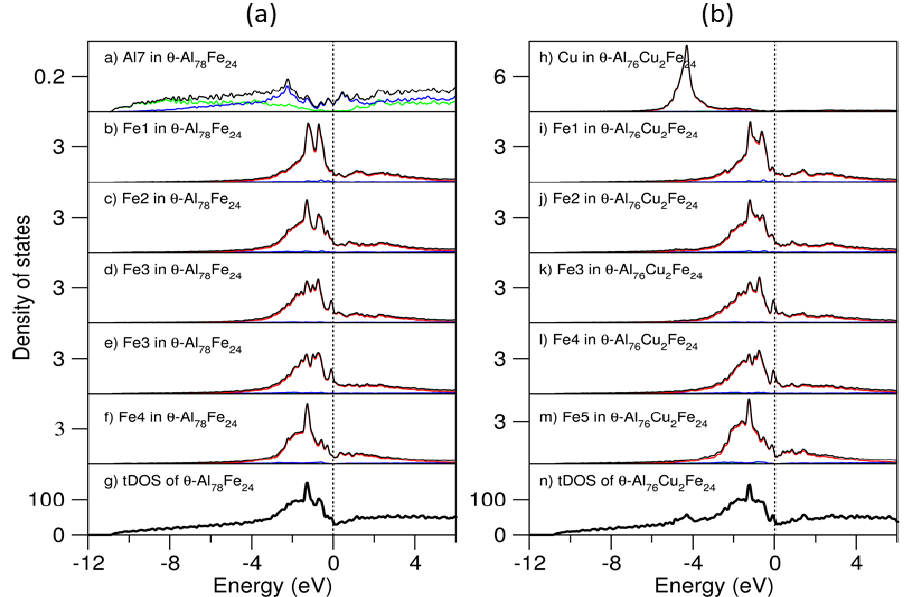
Figure 6. (Color on line) The pDOS of the selected atoms and tDOS curves for the binary θ -Al 78 Fe 24 ( a ) and the θ -Al 76 Cu 2 Fe 24 phase ( b ). For the pDOS, a) to f) and h) to m), the green curves represent contributions from the s-character states, blue the p-character, red the d-character and black the sum of the s, p and d states of the atoms. For both compounds, the DOS curves have one band, starting at − 10.9 eV. The upper part of the valence band from − 3.0 eV to − 0.2 eV is dominated by Fe 3d states, which form